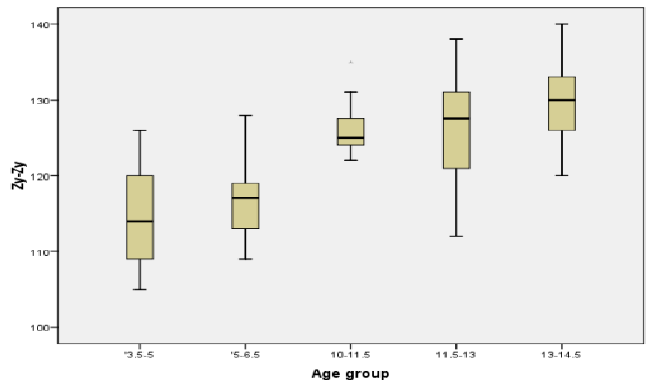
Figure 5. Boxplot for Zy-Zy values.